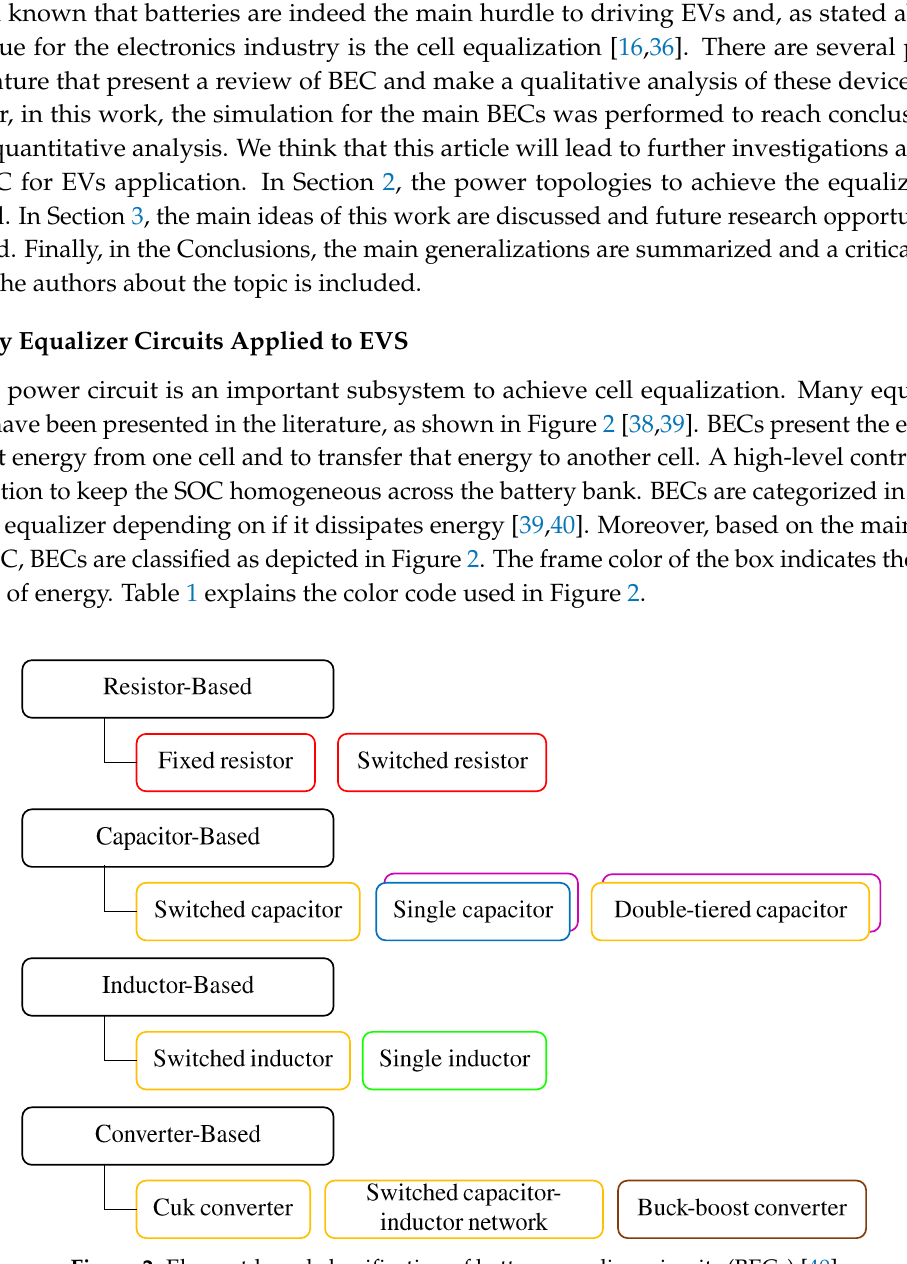
Figure 2. Element-based classification of battery equalizer circuits (BECs)